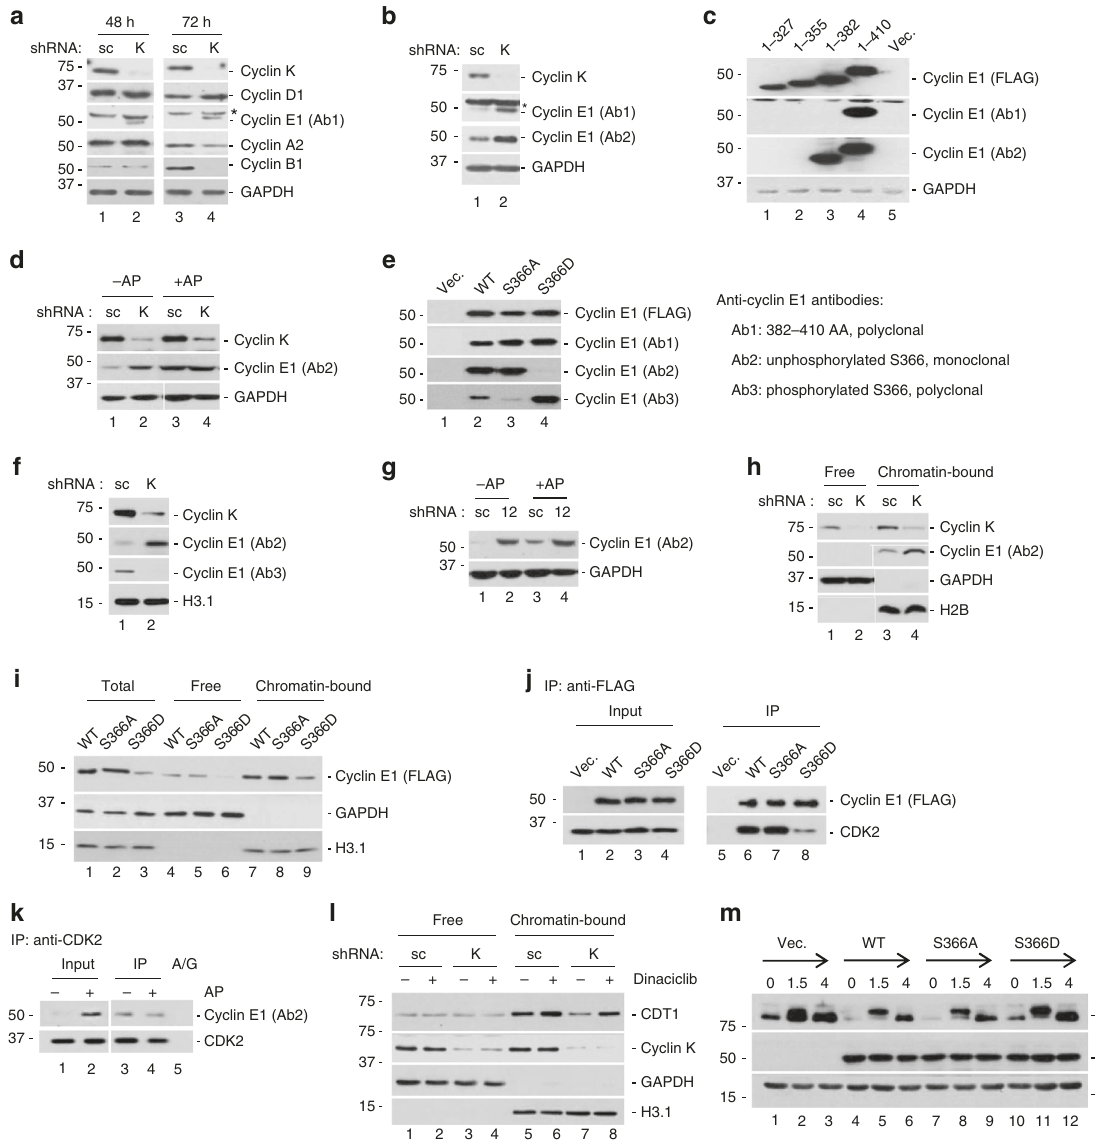
Fig. 5 Cyclin K counteracts cyclin E1 to promote pre-RC assembly. a Expression pro fi ling of cyclin proteins with or without cyclin K knockdown for 48 and 72 h in HCT116 cells. Ab1 denoted a commonly used commercial anti-cyclin E1 polyclonal antibody. Asterisk denoted the non-speci fi c signal detected by several batches of Ab1. b Veri fi cation by a monoclonal anti-cyclin E1 antibody (Ab2). Note that Ab2 only detected the faster mobility band of cyclin E1. c Demarcation of epitope regions of Ab1 and Ab2 by a series of cyclin E1 truncation mutants. 1 – 410 denoted full-length cyclin E1. All proteins were FLAG- tagged at the C-terminus, and expression constructs were transfected into HEK293 cells. d Alkaline phosphatase (AP) treatment of HCT116 cell lysates derived from cells with or without cyclin K knockdown, followed by protein blotting analyses. e Differential recognition of phosphorylation mimics by Ab2 and Ab3. S366A, alanine substitution of serine to mimic unphosphorylated state. S366D, aspartate substitution of serine to mimic phosphorylated state. Expression constructs were transfected into HEK293 cells. Right panel, summary of the speci fi city of antibodies used in Fig. 5. f Endogenous cyclin E1 protein detected by Ab2 and Ab3 with or without cyclin K knockdown in HCT116 cells. g Similar experiment as in d except that CDK12 (12) was knocked down in HCT116 cells. h Detection of endogenous chromatin-bound cyclin E1 by Ab2 with or without cyclin K knockdown in HCT116 cells. i Distribution of wild-type and mutant cyclin E1 proteins in soluble and chromatin-bound fractions derived from HCT116 cells. j Endogenous CDK2 in HEK293 cells was immunoprecipitated by wild-type or mutant cyclin E1 proteins, followed by protein blot analyses. k Endogenous CDK2 in HCT116 cells was immunoprecipitated by anti-CDK2 antibody. Immunoprecipitates were then treated with or without alkaline phosphatase (AP), and associated endogenous cyclin E1 was analyzed. A/G, protein A/G beads without anti-CDK2 antibody. l Small-molecule inhibitor of CDK2 (dinaciclib, 500 nM) partially rescued CDT1 loading defect caused by cyclin K knockdown in HCT116 cells. m S366A and wild-type but not S366D cyclin E1 prevented pre-RC assembly (indicated by MCM4 loading onto chromatin) in HEK293 cells. All experiments were repeated at least three times and representative results are the possibility that S366 phosphorylation might inhibit binding of type and S366A pulled down endogenous CDK2 protein with cyclin E1 onto chromatin. However, this was unlikely the case similar ef fi ciency. In contrast, S366D substitution largely because S366A, S366D and wild-type cyclin E1 proteins exhibited eliminated this interaction (Fig. 5j). We further examined the similar binding af fi nity to chromatin (Fig. 5i). FLAG-tagged wild- signi fi cance of S366 phosphorylation on endogenous proteins.